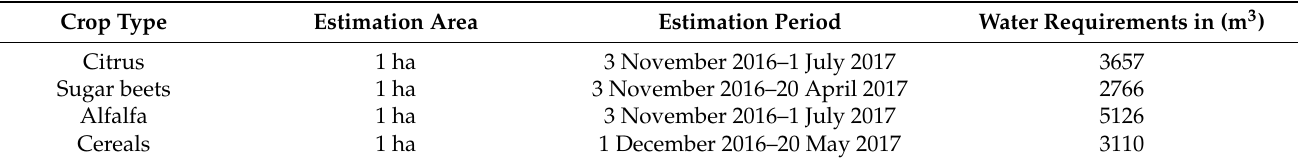
Table 2. Seasonal accumulation of crop water requirements.